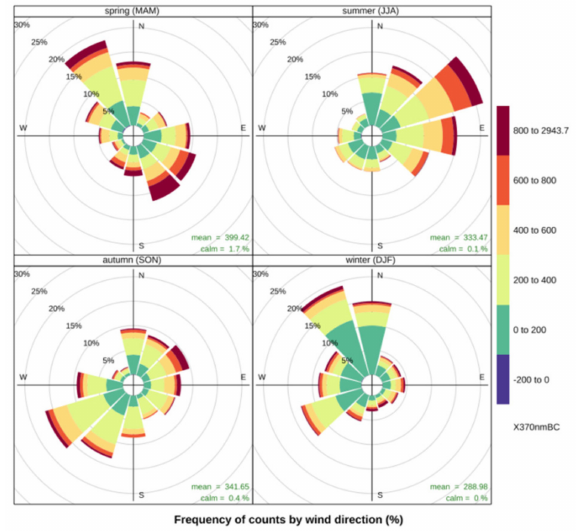
Figure 5. Wind rose of black carbon concentration for the four seasons and the whole year over 24 years.